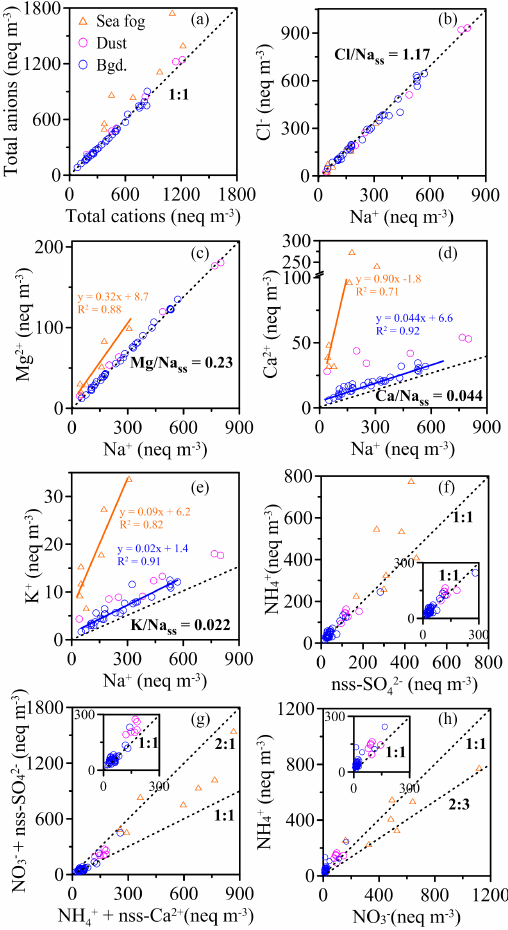
Figure 5. Scatter plots for equivalent concentrations of specific ions. (a) Total anions vs. total cations, (b) chloride vs. sodium, (c) magnesium vs. sodium, (d) calcium vs. sodium, (e) potassium vs. sodium, (f) ammonium vs. nss-sulfate, (g) P (nitrate + nss- sulfate) vs. P (nss-calcium + ammonium) and (h) nitrate vs. am- monium. Orange, pink and blue are for sea-fog-modified, dust and background aerosols,